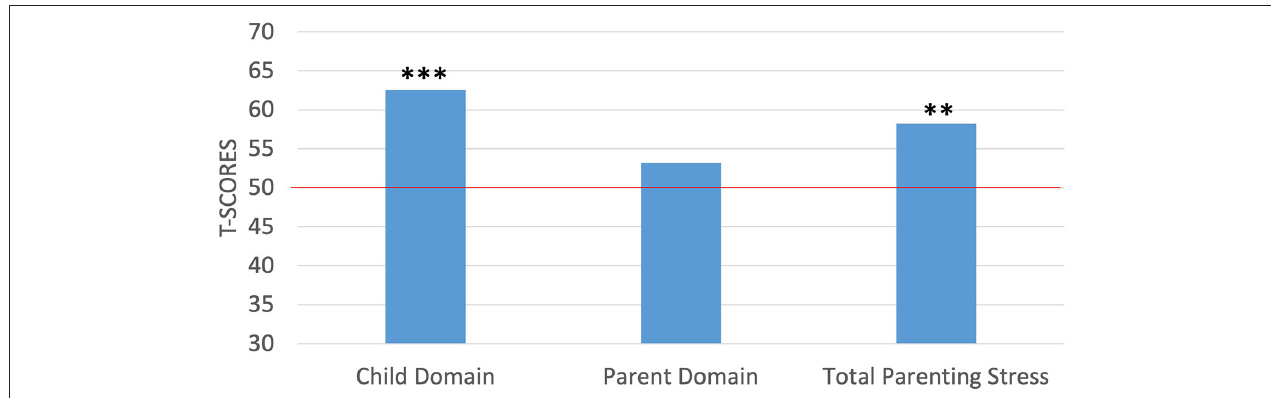
FIGURE 2 | One-sample t -tests between maternal self-report of parenting stress against the normed sample of the PSI-4. *** p < 0.001 ; ** p < 0.01. Red horizontal line indicates the normed sample mean of 50.